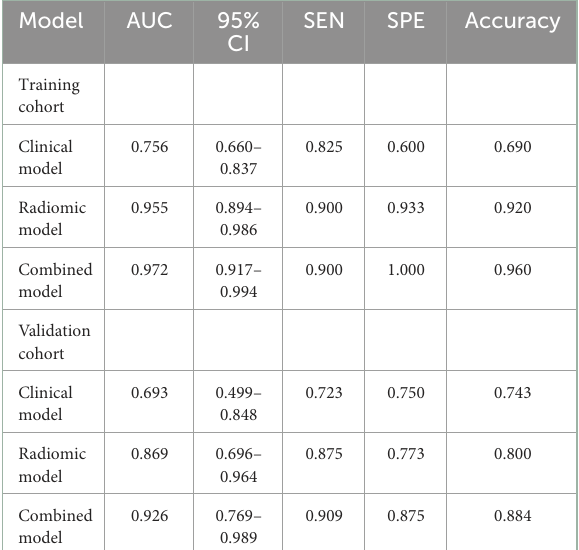
threshold probabilities in classifying hemorrhage and contrast TABLE 3 Comparisons of ROC curves of classification models in the training and validation